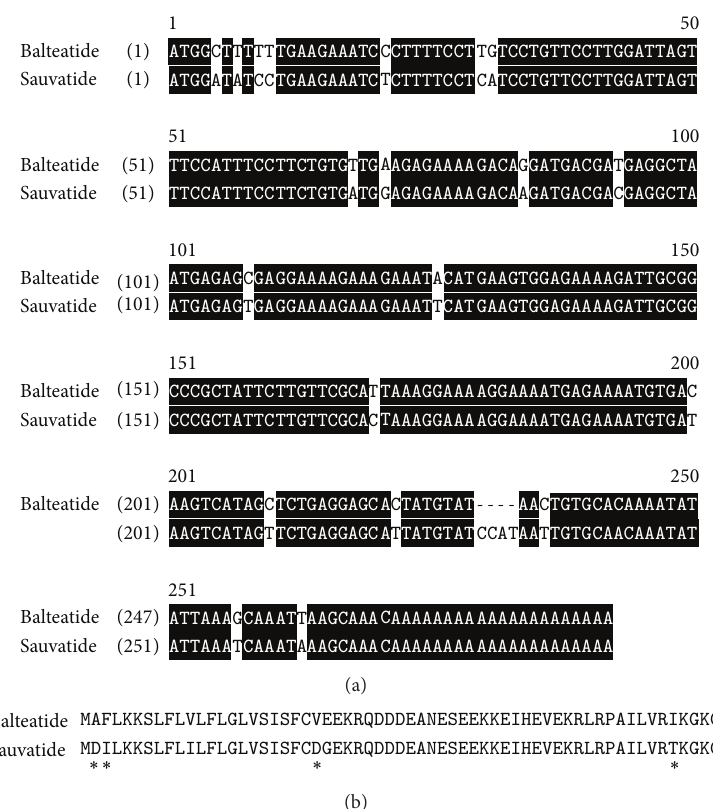
Figure 3: (a) Alignment of the nucleotide sequences of cDNAs encoding balteatide and sauvatide precursors. Identical bases in both are back-shaded in black. (b) Alignment of translated open-reading frame amino acid sequences of balteatide and sauvatide precursors. Sites of amino acid residue differences are indicated by asterisks. Table 1: Mean inhibitory concentrations (MICs) of each antimicrobial agent against the three model test microorganisms employed. MICs (mg/L and 𝜇 M) E. coli S. aureus C. albicans Balteatide 128 mg/L (109 𝜇 M) > 512mg/L (435 𝜇 M) 32 mg/L (27 𝜇 M) Sauvatide > 512mg/L (439 𝜇 M) 512mg/L (439 𝜇 M) 512mg/L (439 𝜇 M) Melittin 16 mg/L (6 𝜇 M) Ampicillin NE: not